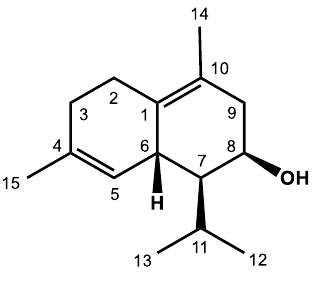
Figure 3. Structure of compound 56 . Table 3. NMR data of compound 56 .